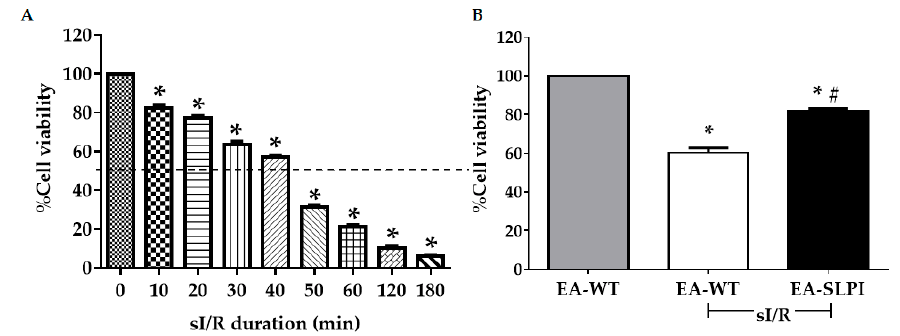
Figure 3. Determination of SLPI-overexpressing EA.hy926 cells in ischemia / reperfusion (I / R). ( A ) EA.hy926 cells were subjected to 10–180 min simulated ischemia (sI) followed by 24 h of reperfusion; ( B ) Wild-type (EA-WT) and SLPI-overexpressing (EA-SLPI) EA.hy926 cells were exposed to 40 min of sI followed by 24 h reperfusion, and the cell viability was determined by MTT. Each bar represents the mean ± SEM. * p < 0.05 vs. non-sI/R-treated group (ANOVA), # p < 0.05 vs. the sI/R-treated group (ANOVA, n = 3).